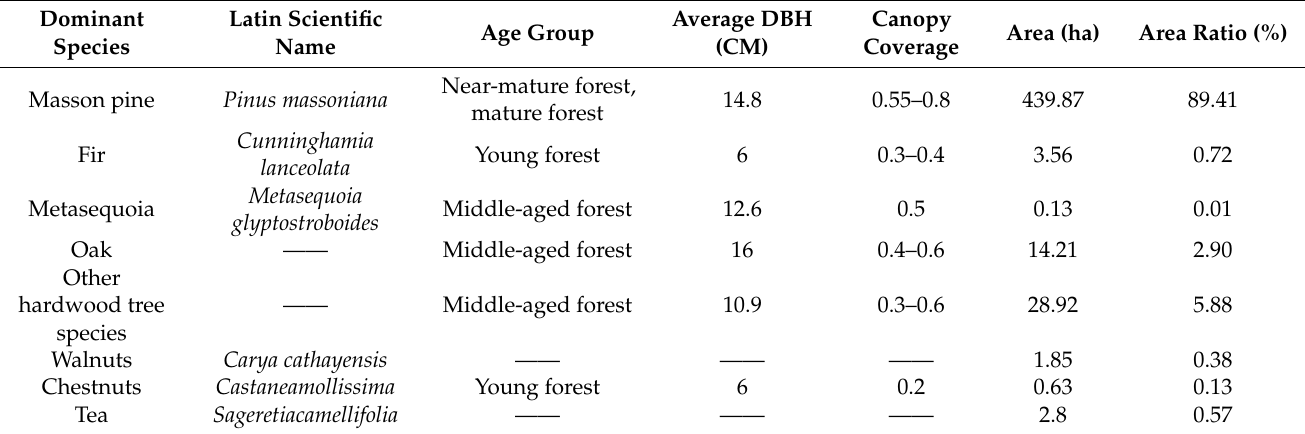
Table 2. List of dominant species in South Lake Scenic Area.